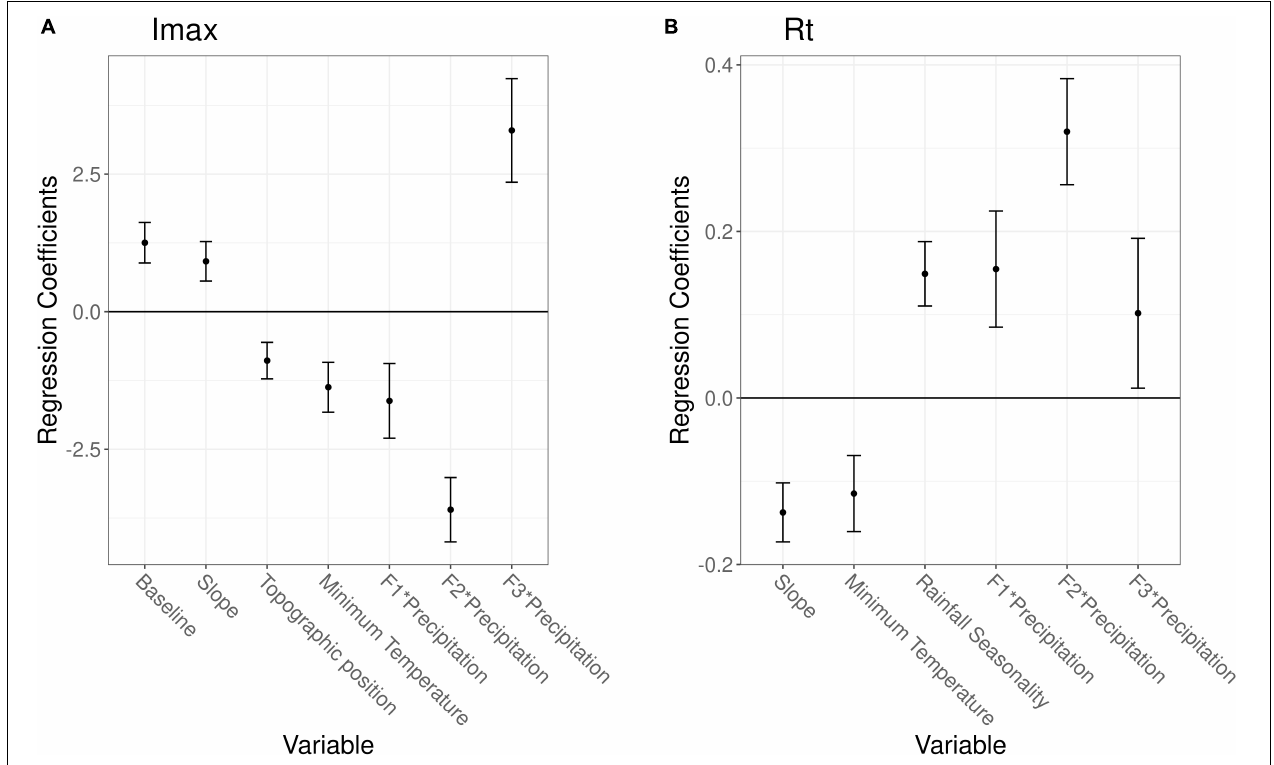
FIGURE 4 | Regression coefficients for several variables predicting the maximum impact I max (A) or the recovery time Rt (B) . A multiple linear regression and generalized linear model with negative binomial distribution were used to predict I max or Rt, respectively. Error bars show standard errors and interactions are indicated by an asterisk. Estimates for the regression model intercepts are not